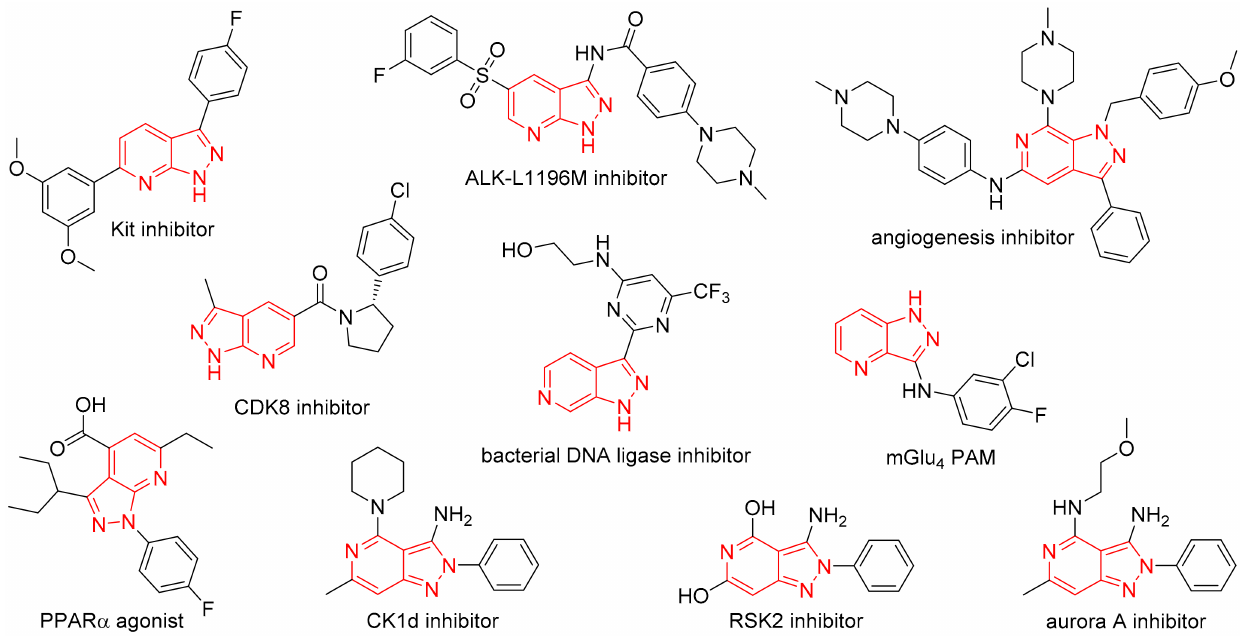
Figure 1. Selected examples of biologically relevant